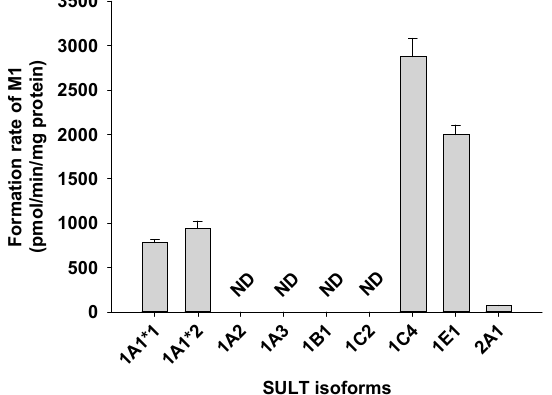
Figure 4. Rate of formation of catalposide sulfate (M1) from 150 µ M catalposide by human cDNA-expressed SULT enzymes. All data are means ± SD ( n = 3). ND: < 32 pmol / min / mg protein.